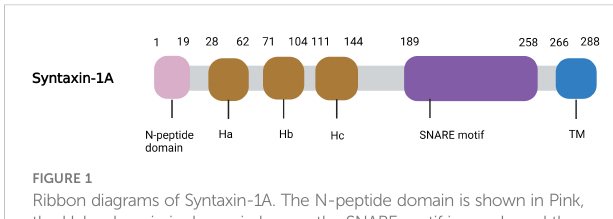
FIGURE 1 Ribbon diagrams of Syntaxin-1A. The N-peptide domain is shown in Pink, the Habc domain is shown in brown, the SNARE motif in purple and the TM in